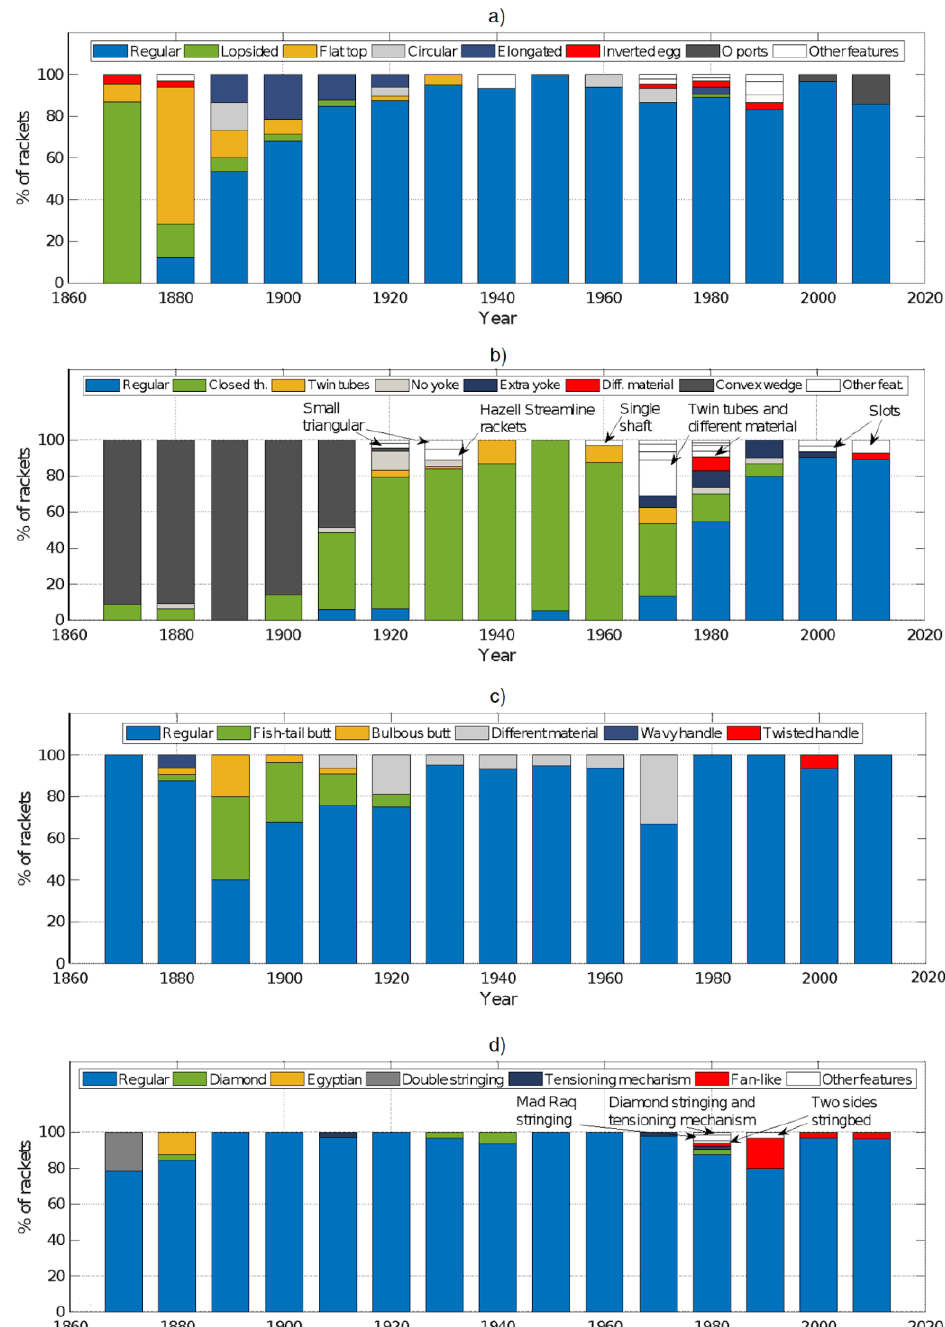
Figure 4. Bar charts showing the percentage of rackets with certain distinguishing features per decade; ( a ) head; ( b ) throat; ( c ) handle and ( d ) stringing pattern. Other features correspond to cases were there were less than five examples.